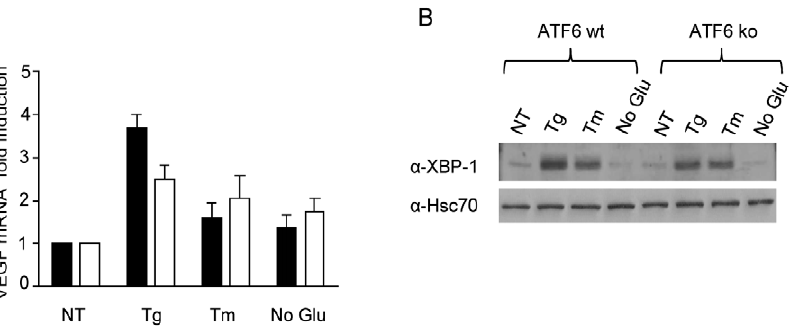
Figure 6. ATF6 does not significantly contribute to VEGF expression. ( A ) ATF6 wild-type (black) or null (white) MEFs were untreated (NT), thapsigargin-treated (1 m M), tunicamycin-treated (2.5 m g/ml) or treated with media lacking glucose (No Glu) for 6 hours. Total RNA from the indicated samples was subjected to qRT-PCR, and the VEGF mRNA levels were determined. ( B ) XBP-1(S) was detected using western blot analysis on cell lysates from ATF6 wild-type and null MEFs that were untreated or treated as indicated. Experiments were performed in triplicate (values are mean 6 SD).